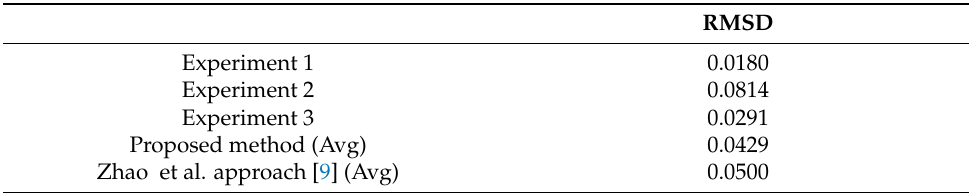
Table 2. Accuracy of glass